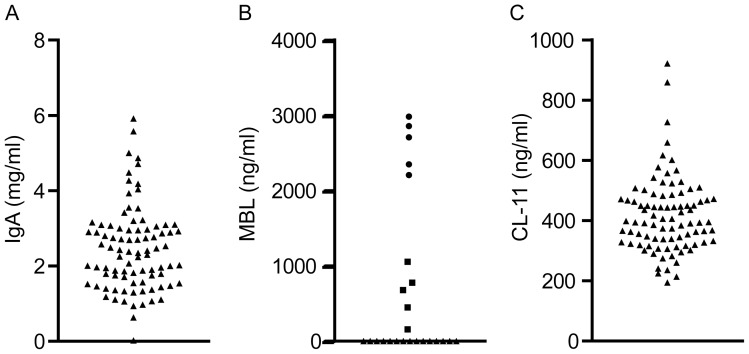
Serum concentrations of IgA, MBL and CL-11.
A) IgA serum concentration (mg/ml). One CRS patient with a suspected IgA deficiency (<0.021 mg IgA/ml) was identified. B) Serum levels of MBL (ng/ml) in the 15 patients with non-detectable MBL pathway activity (triangles). Positive controls illustrated with serum levels of MBL in five genotyped individuals homozygous (circles) or heterozygous (squares) for structural MBL wild type alleles. C) Serum levels of CL-11 (ng/ml) among CRS patients. No CL-11 deficient patients were found.